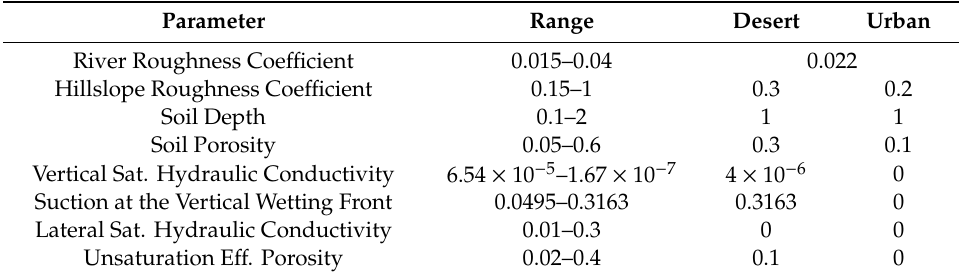
Table 3. Resulting parameters from the calibration process.